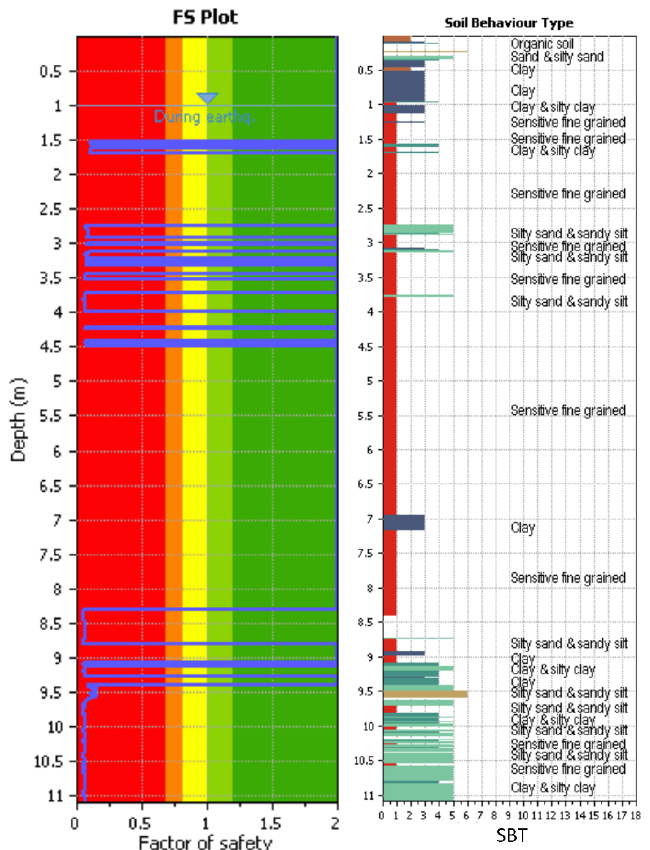
Figure 21. CPT liquefaction triggering results and SBT plot for Site 4 (modified from Anderson [40]).